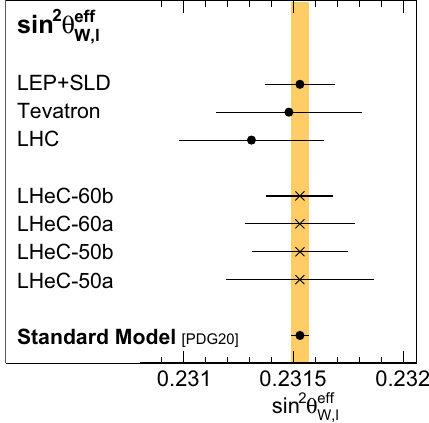
Fig. 6 Comparison of determinations of the weak mixing angle. The results from LEP+SLD [62], Tevatron [72], LHC [73–76] and the SM value refer to the leptonic weak mixing angle, sin 2 θ eff , and include W ,(cid:11) the information about the W - and Z -boson masses [76]. They are all obtained from a combination of various separate measurements (not shown individually) (see also Ref. [68] for additional information). Two scenarios for the simulation of LHeC inclusive NC/CC DIS data are considered. Here, the estimated uncertainties refer to the fermionic effective weak mixing angle, sin 2 θ eff . With real data, the central val- W , f ues will have to be mapped to each other by taking into account the proper κ -factors, see Eqs. (22,